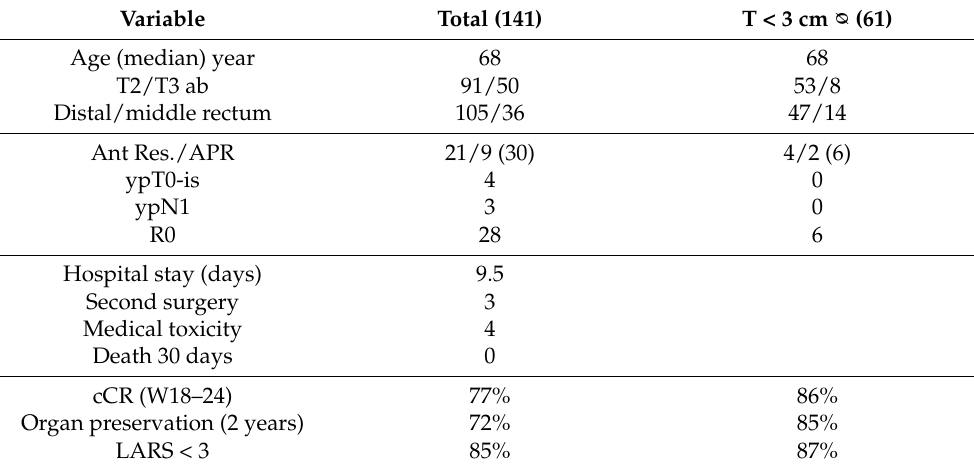
Figure 1. Illustration of CXB. ( Left ): The Papillon 50 TM system. Thick arrow: X-ray tube, also called a micronode. Plastic pipe (thin arrow) to circulate the mineral oil from the stand floor to the X-ray tube for anode cooling and allowing for a high dose rate (15 Gy/min). ( Upper right ): A treatment session. Patient in the knee–chest position. The rectal applicator is introduced in contact with the tumor under eye guidance and fixed (fisso arm). The X-ray tube is introduced into the rectal appli- cator to deliver the dose. ( Lower right ): Schematic drawing showing the X-ray tube introduced through the applicator in contact with the tumor. The FSD (focus surface distance is 4 cm). The focus is the anode (arrow) producing the 50 kV X-rays. Illustration of the dose distribution showing a sharp fall-off of the dose, which is 30 Gy at tumor surface (red) and 50% at 5 mm (green). There is nearly no dose to the rest of the rectal wall and surrounding tissues. It is a fully ambulatory treat- ment with good